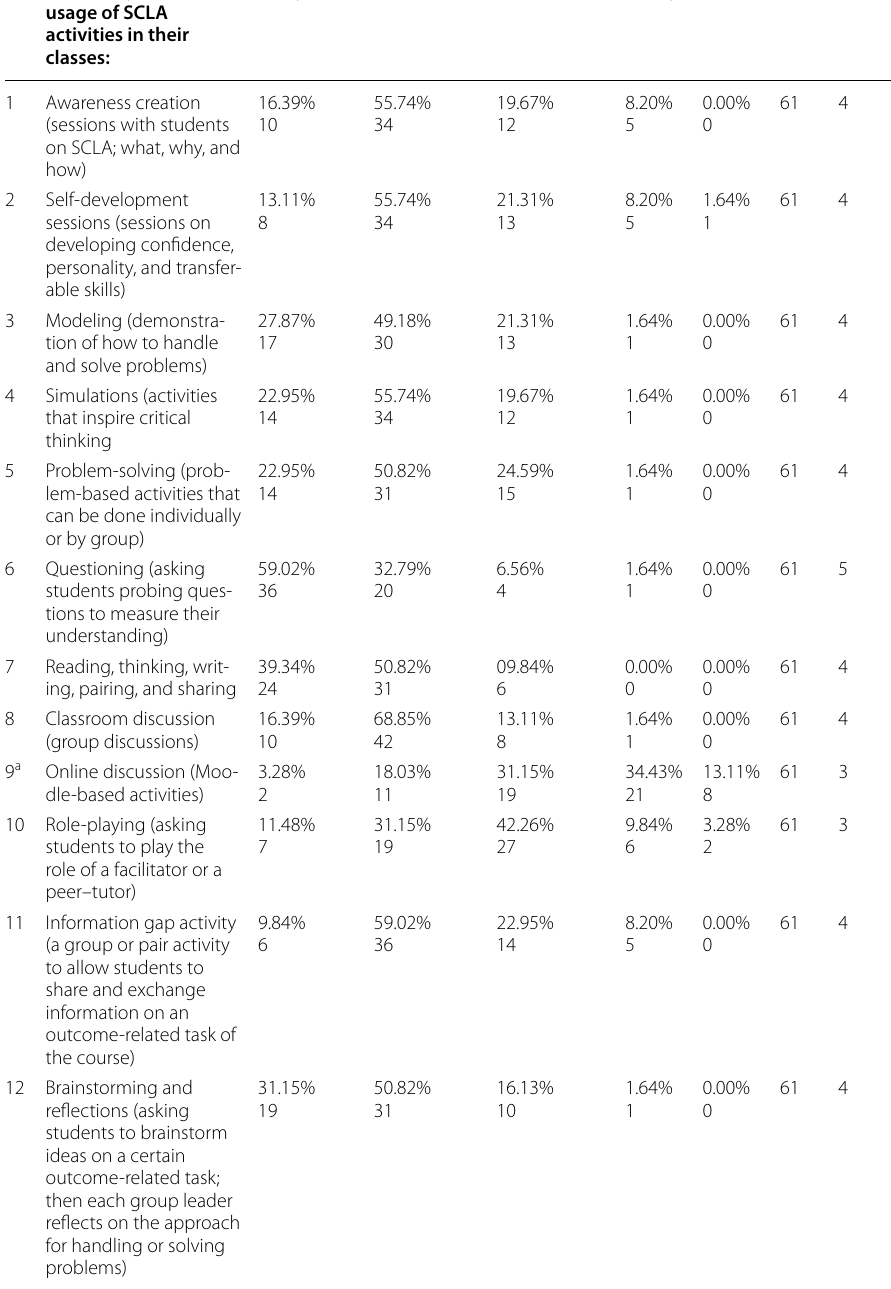
Table 5 Teachers’ practices of